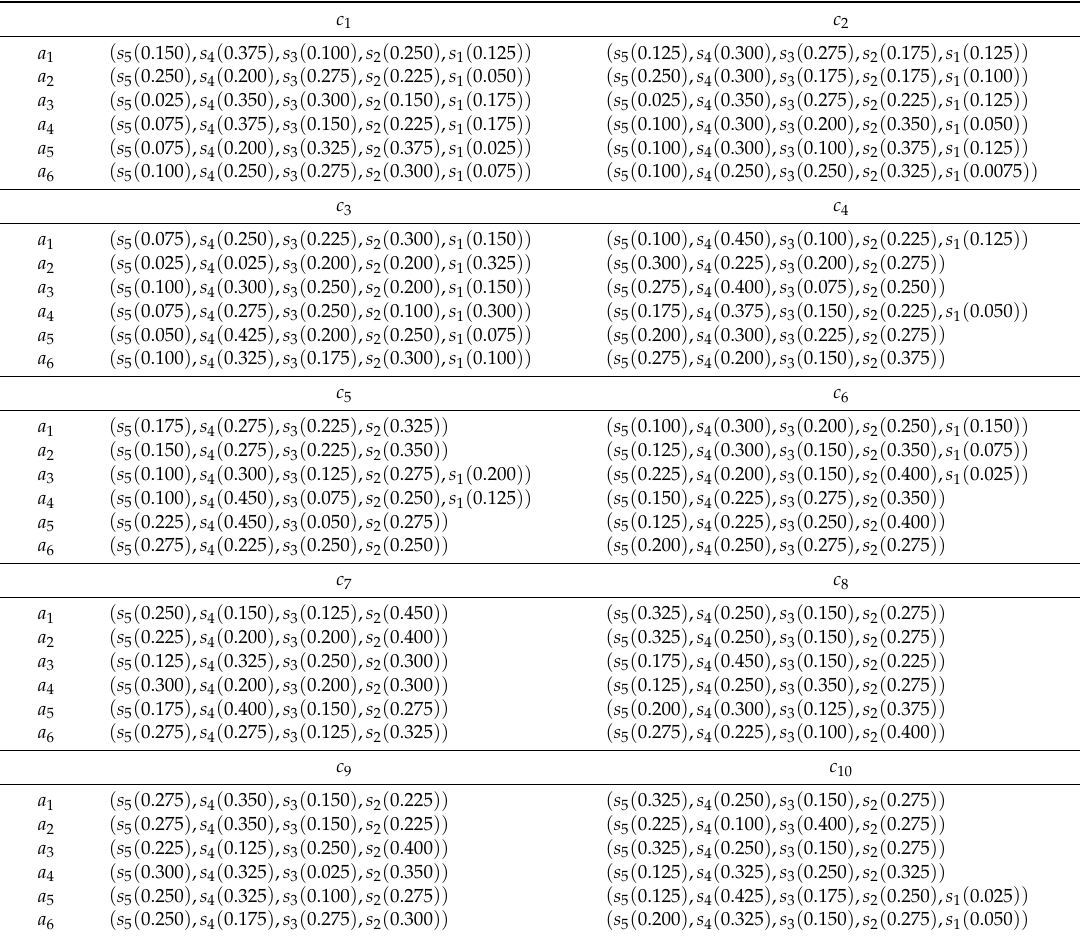
Table A3. The PLTSs-based evaluation